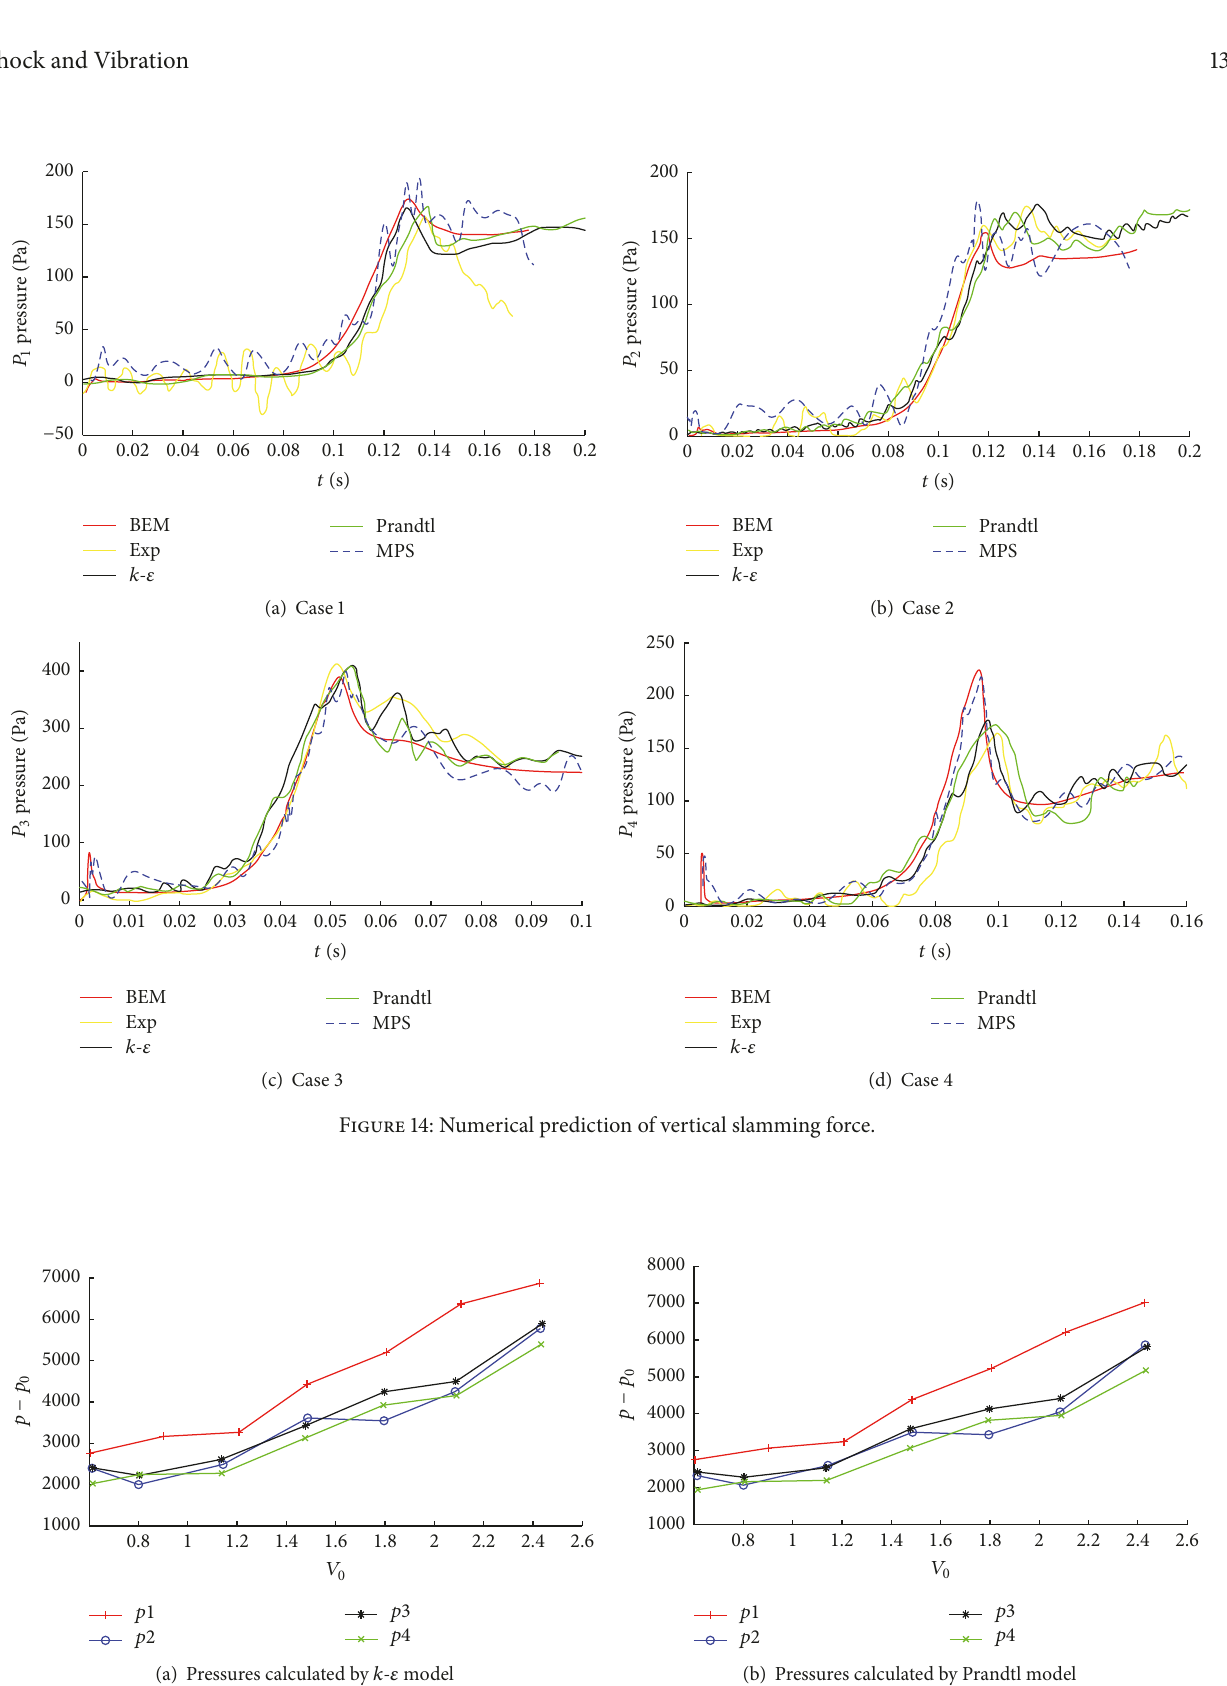
Figure 15: Vertical water